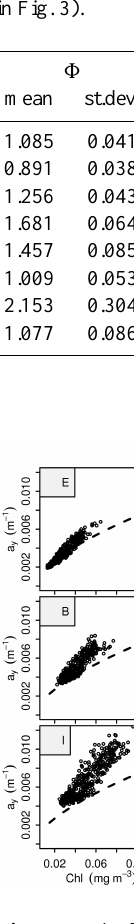
Fig. 4. For the left hand column (sites in the Southern Hemisphere) the year starts with January (Ja); for the right hand column (North- ern Hemisphere) the year starts with July (Ju); by this way, the win- ter solstice is in the middle of the figures, whatever the hemisphere. (a) Spatially averaged quantities [Chl] (via OC4 algorithm), and a y (443) (via Eq. 1) from eight-day composites for each zone; the dashed curve represents the relationship when 8 = 1; above and be- low this curve are the domains where 8 is > 1 or < 1, respectively. (b) Corrected [Chl] versus nominal [Chl] for each zone; the black line is the 1:1